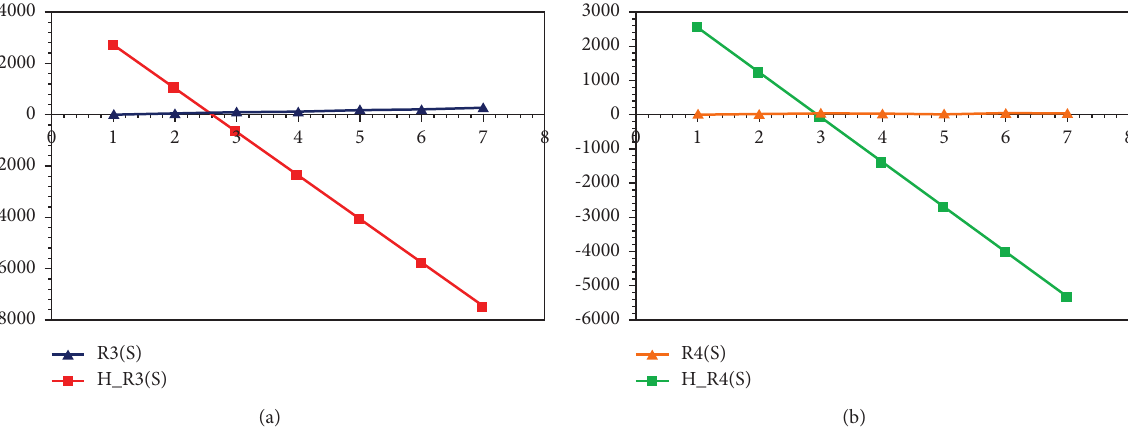
Figure 4: (a) Randi c index for α � 1/2 with heat of formation, (b) Randi c index for α � − 1/2 with heat of formation.